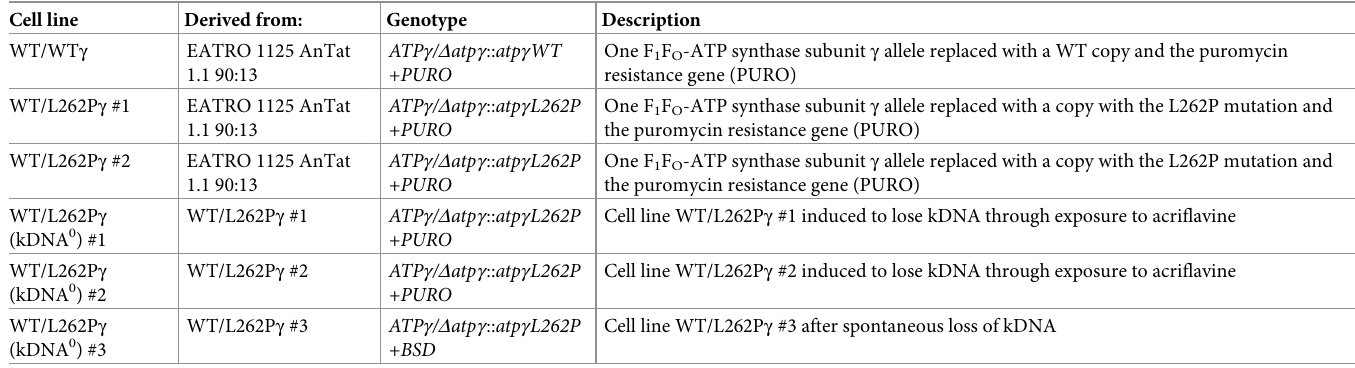
Table 1. Cell lines used in this